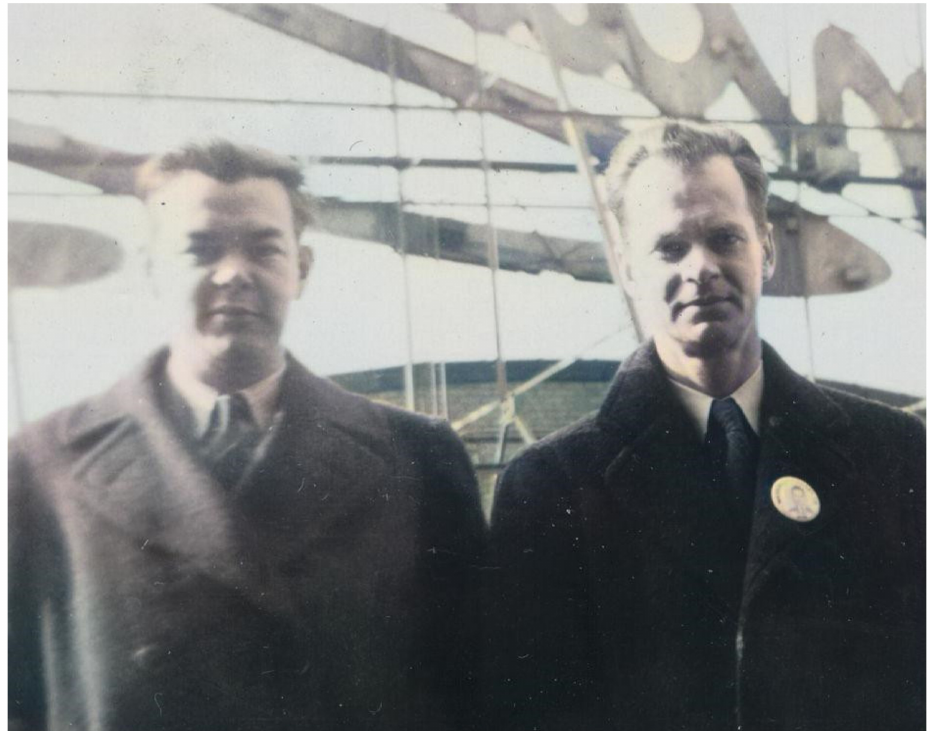
Figure 1. Colorized photo of Keller Breland (left) and B. F. Skinner on top of the General Mills building in Minneapolis, MN, USA, circa 1943. (Photo courtesy of Robert E. Bailey).